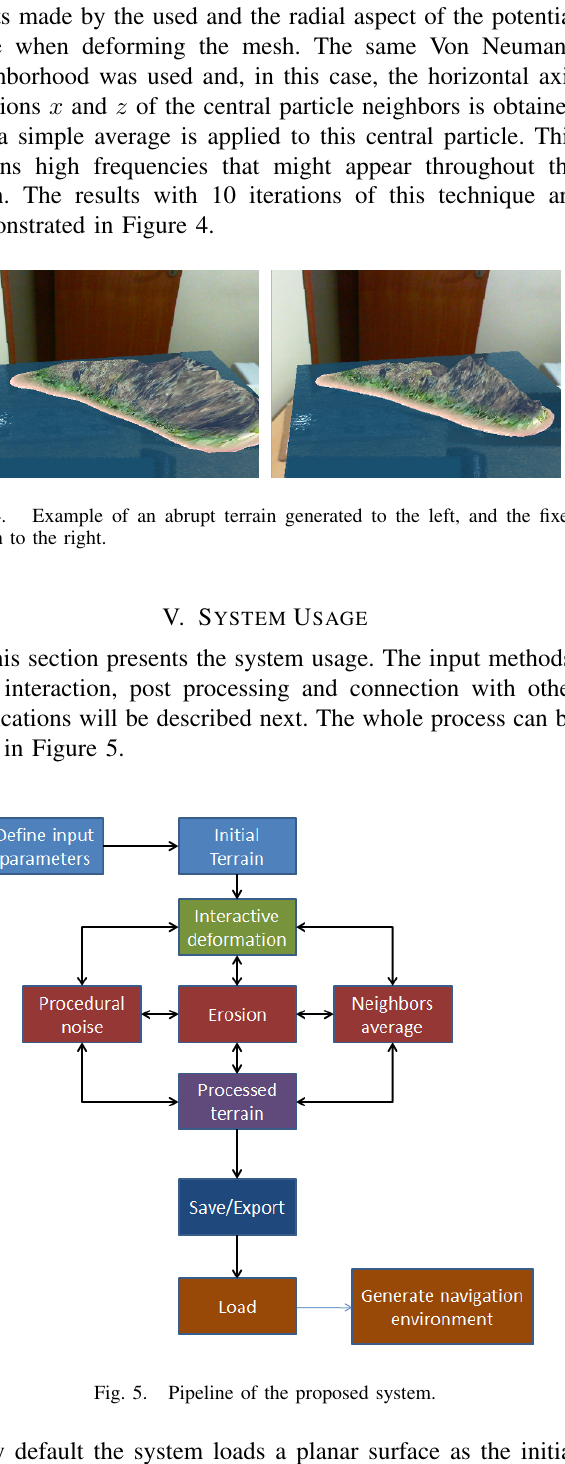
Fig. 5. Pipeline of the proposed system.